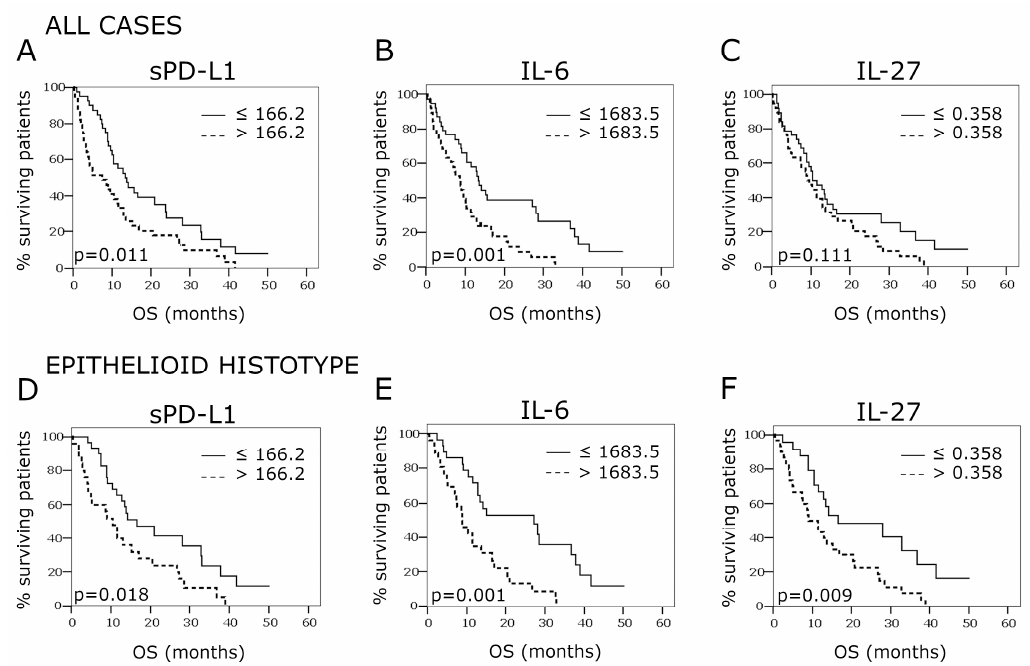
Figure 4. Kaplan–Meier curves assessing overall survival according to sPD-L1, IL-27, and IL-6 concentrations in the pleural effusion, as dichotomized around their respective median value. Analyses with respect to all cases ( n = 77) (panels A – C ) and the subgroup with the epithelioid histotype (n = 55) (panels D – F ) are shown.